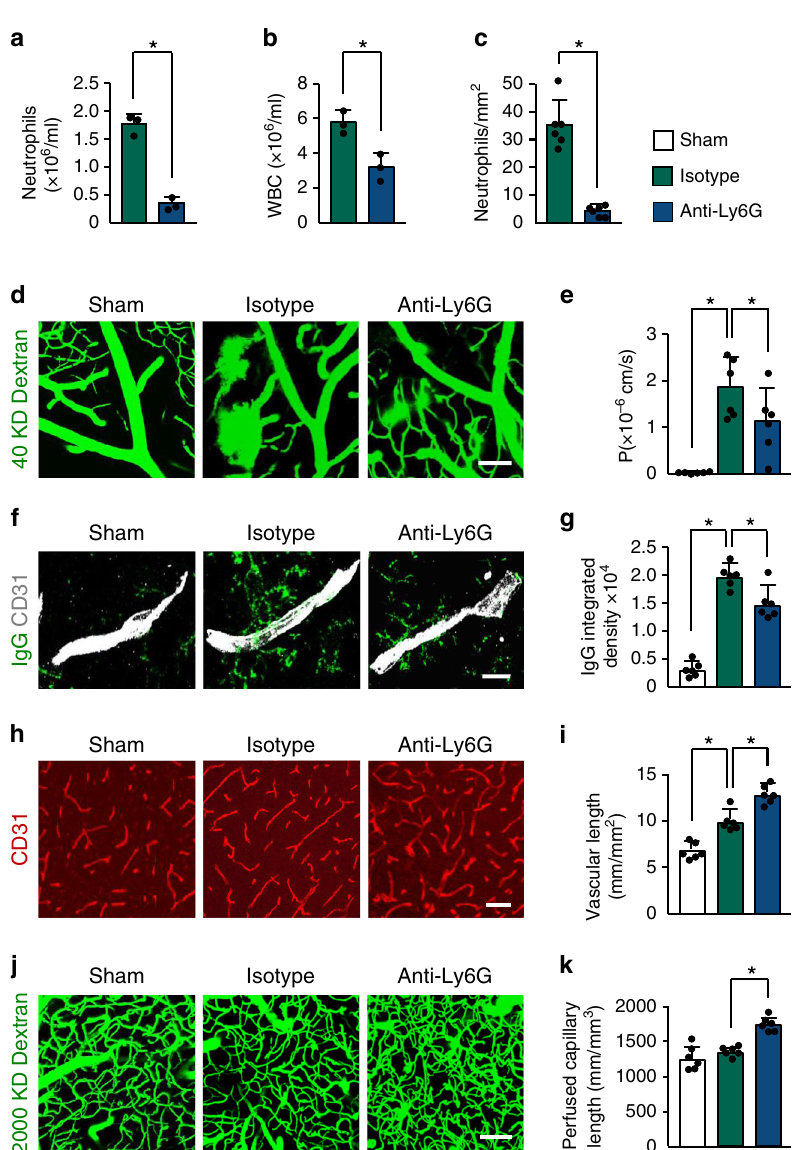
Fig. 2 Neutrophil depletion reduces BBB breakdown and increases neovascularization after stroke. a , b Neutrophil and white blood cell counts in peripheral blood at 14 days after stroke in mice treated with control antibody or anti-Ly6G antibody ( n = 3), unpaired two-tailed Student ’ s t -test was applied with * P = 0.0003 ( a ), * P = 0.012 ( b ). WBC, white blood cell. c Quanti fi cation of the number of neutrophils in the ischemic cortex at 14 days in mice treated with control antibody or anti-Ly6G antibody ( n = 6 biologically independent experiments), Mann – Whitney test was applied with * P = 0.0022. d , e Representative in-vivo multiphoton microscopic images of intravenously injected FITC-dextran (MW = 40,000Da; green) leakage in cortical vessels ( d ) at 14 days in sham-operated mice and ischemic mice treated with control antibody or anti-Ly6G antibody, and quanti fi cation of the permeability (P) product of FITC-dextran for each group ( e ) ( n = 6). One-way ANOVA test was applied with * P = 0.0001 (Sham vs. Isotype), * P = 0.0354 (Isotype vs. Anti-Ly6G). Bar = 100 μ m. f , g Representative confocal images ( f ) and quantitative analysis of IgG extravascular deposits ( g ) in the peri-infarct cortex at 14 days in sham-operated mice and mice treated with control antibody or anti-Ly6G antibody ( n = 6). One-way ANOVA test was applied with * P < 0.0001 (Sham vs. Isotype), * P = 0.0041 (Isotype vs. Anti-Ly6G). Bar = 15 μ m. h , j Representative confocal images ( h ) of CD31-positive microvessels and in-vivo multiphoton microscopy images of perfused cortical capillaries with intravenously injected FITC-dextran (MW = 2000,000 Da) ( j ) in the peri-infarct cortex at 14 days in mice treated with control antibody or anti-Ly6G antibody, compared with sham-operated mice. Bar = 50 μ m ( e ) and 100 µ m ( g ). i , k Quanti fi cation of microvascular density ( i ) and perfused capillary length ( k ) for each group ( n = 6). One-way ANOVA test was applied with * P = 0.0003 (Sham vs. Isotype ( i )) * P = 0.0004 (Isotype vs. Anti-Ly6G ( i )), * P = 0.0002 (Isotype vs. Anti-Ly6G ( k )). Data are presented as mean ± SD. Source data underlying graph a – c , e , g , i , and k are provided as a Source Data fi PAD4 regulates BBB permeability and neovascularization . signi fi cant increases in microvascular length (Fig. 5e, f) and perfused cortical vessels (Fig. 5i, j) in anti-Ly6G antibody-treated Peptidylarginine deiminase 4 (PAD4) is a histone-modifying mice compared with control IgG-treated mice. Treatment with enzyme that is critical for NET formation 30,31 . Quantitative PCR revealed a sustained 29.3-fold increase in PAD4 mRNA expres- DNase 1 starting at 7 days after stroke also attenuated BBB sion in the ischemic cortex at 3 days after stroke compared with disruption (Fig. 5c, d), increased microvessels (Fig. 5g, h), and sham-operated brains (Fig. 6a). Immunoblotting found a marked improved capillary perfusion (Fig. 5k, l) at 14 days.